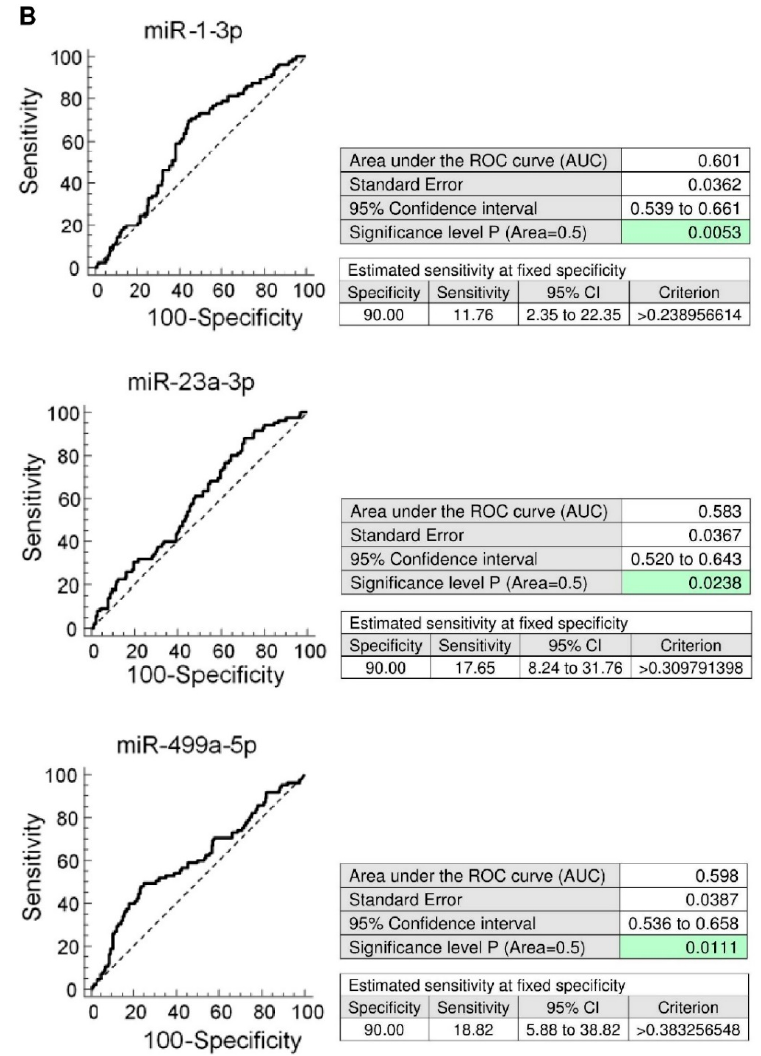
Figure 3. Higher expression rates of miR-1-3p, miR-23a-3p, miR-499a-5p in whole peripheral blood of young and middle-aged women with the presence of vascular endothelial dysfunction. ( A ) Higher expression rates of miR-1-3p, miR-23a-3p, and miR-499a-5p were detected in whole peripheral blood of young and middle-aged women with the occurrence of vascular endothelial dysfunction (RHI ≤ 1.67) when compared with those possessing normal vascular endothelial function (RHI > 1.67), respectively. ( B ) At 10.0% FPR, a proportion of women with the occurrence of vascular endothelial dysfunction was identified to have up-regulated expression profile of miR-1-3p (11.76%), miR-23a-3p (17.65%), and miR-499a-5p (18.82%). At 10.0% FPR, a proportion of young women with the occurrence of vascular endothelial dysfunction was identified to have up-regulated expression profile of miR-1-3p (AUC 0.0601, p = 0.005, sensitivity 11.76%), miR-23a-3p (AUC 0.583, p = 0.024, sensitivity 17.65%), and miR-499a-5p (AUC 0.598, p = 0.011, sensitivity 18.82%) (Figure 3). The dysregulation of these three microRNAs was mutually independent. All these 3 microRNAs were simultaneously dysregulated just in four patients with abnormal RHI values. MiR-1-3p dysregulation was followed by miR-23a-3p dysregulation just in 1 patient with abnormal RHI values. MiR-1-3p dysregulation was followed by miR-499a-5p dysregulation also just in 1 patient with abnormal RHI values. The various combinations of miR-1-3p, miR-23a-3p, and miR-499a-5p were not superior over using only